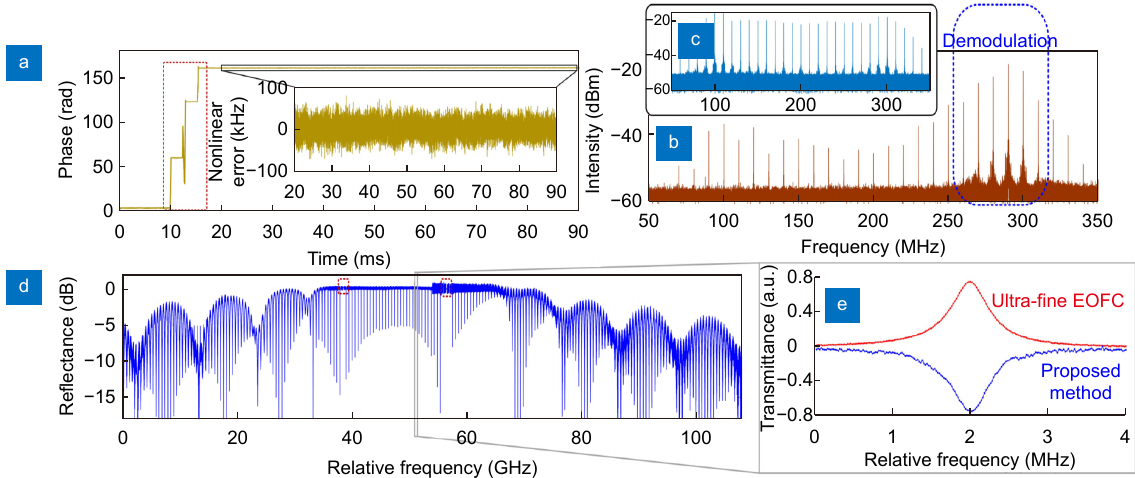
Fig. 7 | ( a ) Unwrapped phase and nonlinear error of the swept optical source with 18 GHz sweep range and 90 ms sweep time. Electrical spec- trum of ( b ) measurement branch and ( c ) reference branch, in which six lines circled are demodulated. ( d ) Demodulated reflectance spectrum of a fiber F-P cavity with 20 kHz spectral resolution. The points during the phase hopping circled in red are removed. ( e ) A resonance with 600 kHz FWHM measured by using the proposed method and